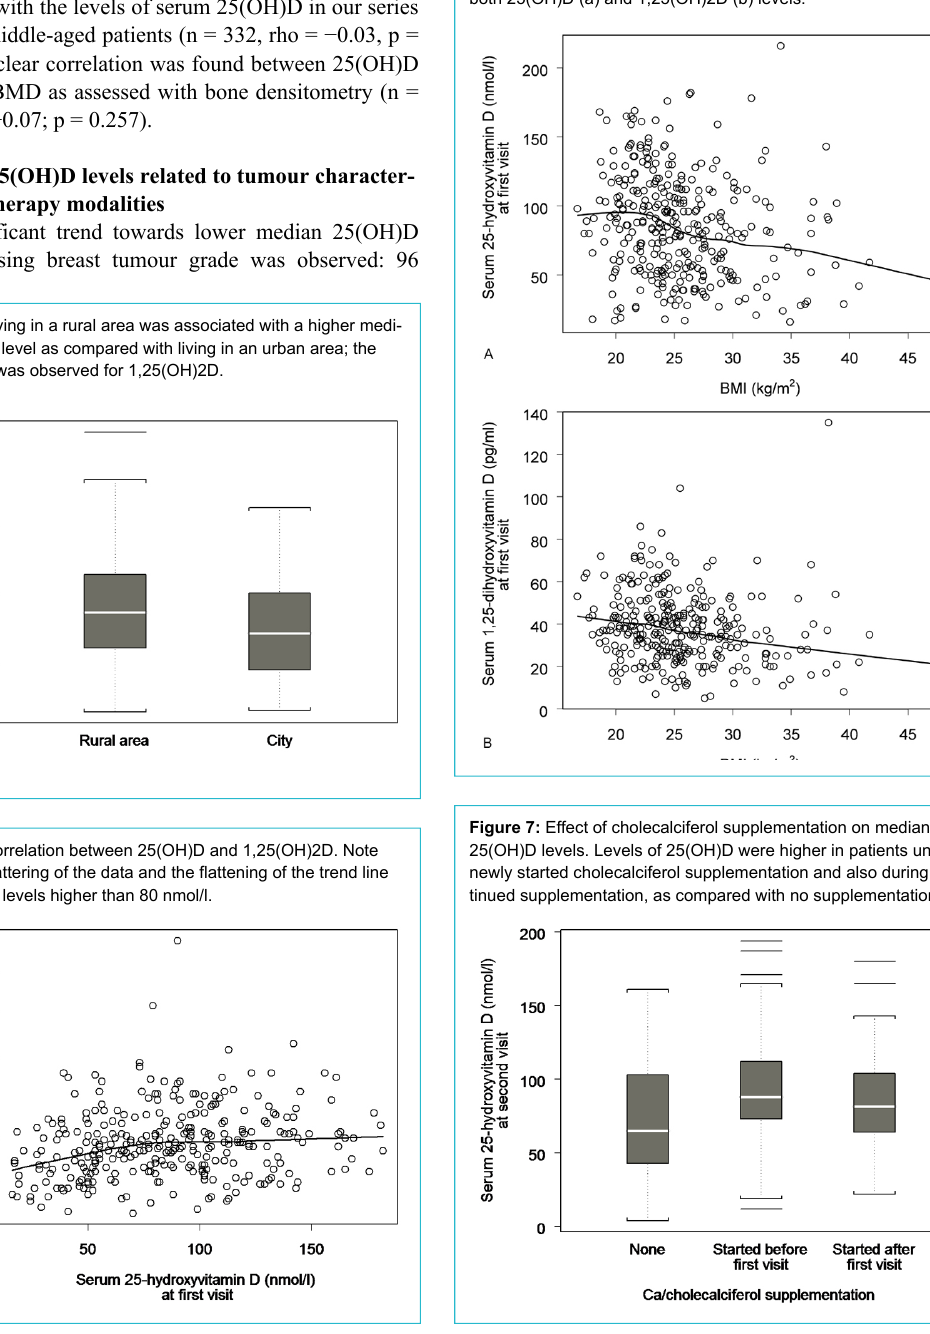
Figure 6: Body mass index (BMI, kg/m 2 ) was inversely related to both 25(OH)D (a) and 1,25(OH)2D (b) levels.